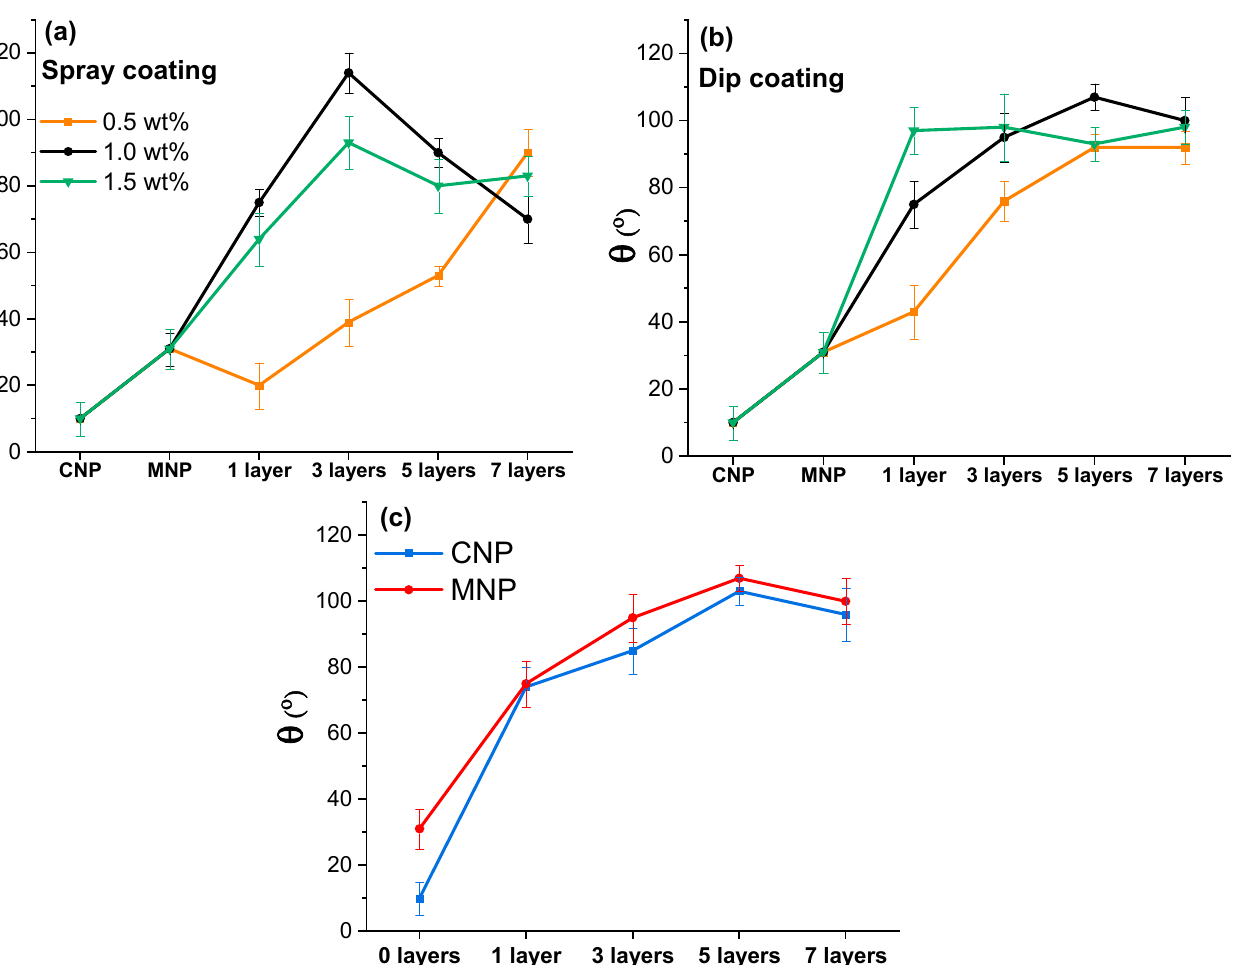
Figure 6. ( a ) Spray-coating and ( b ) dip-coating up to 7 layers of pine wax solution with different concentrations on the MNP. ( c ) Comparison of contact angle values for CNP and MNP using the dip-coating method with up to 7 layers of 1 wt.% pine wax solution.